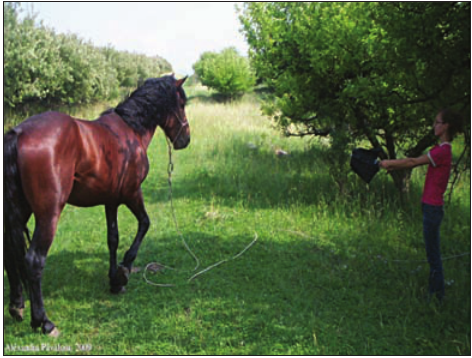
Fig. 1. Preparation for the umbrella test